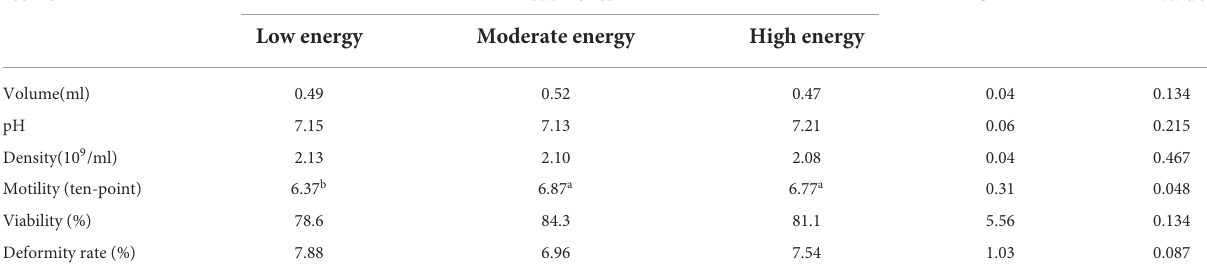
TABLE 4 Effects of different energy levels on semen